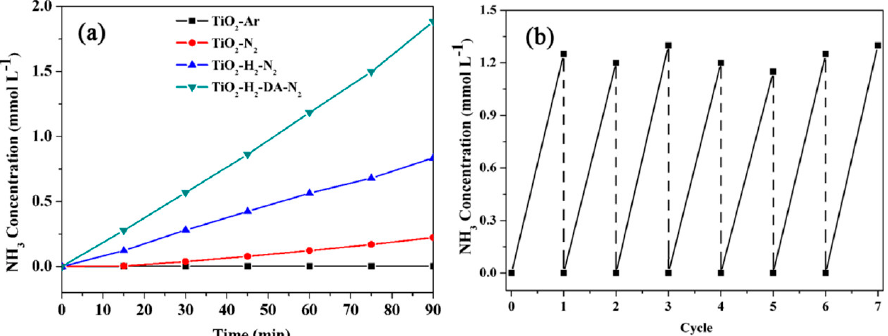
Figure 20. ( a ) Photocatalytic nitrogen fixation activities of different photocatalysts, ( b ) photocatalytic nitrogen fixation cycle activities of TiO 2 –H 2 –DA. Reprinted with permission from [278].